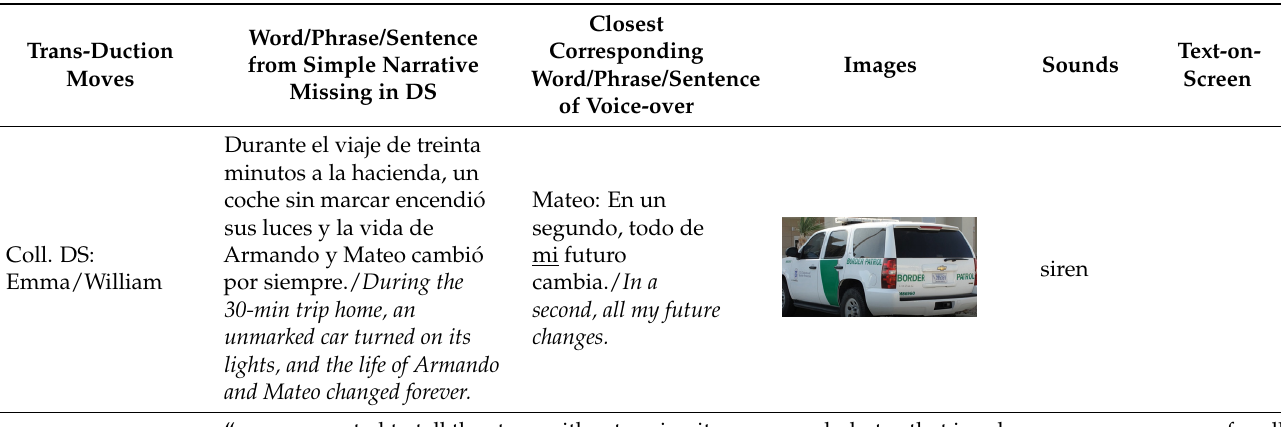
Table 5. Pair 4: example table of transduction moves and implicit images.